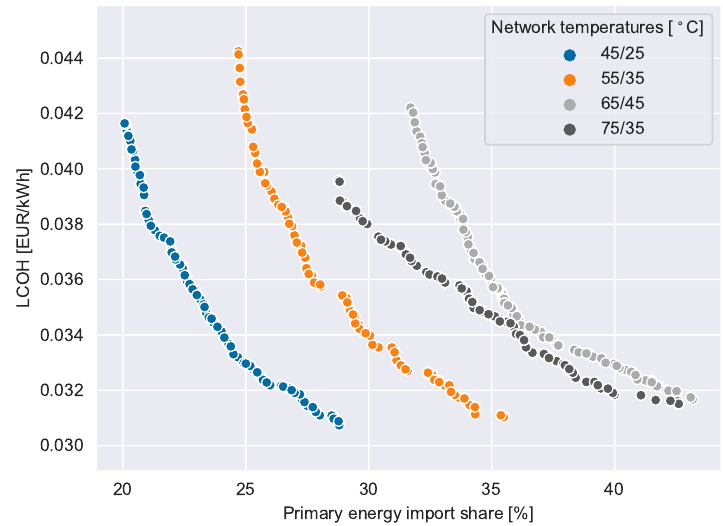
Figure 16. Comparison of the Pareto-optimal solutions for the different temperature scenarios. The excess heat cost is fixed at